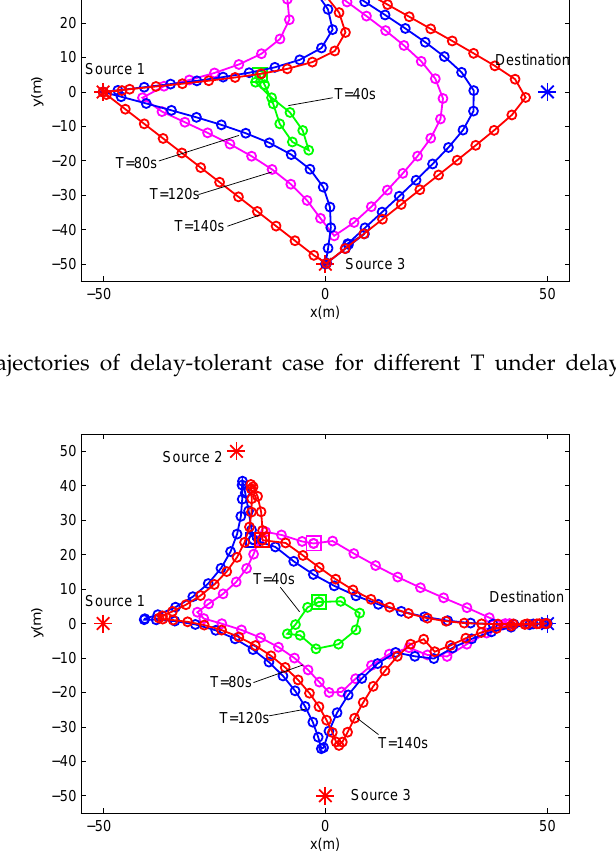
Figure 8. The trajectories of delay-sensitive case for different T under delay-sensitive case with λ = ( 1,1,1 ) , υ =